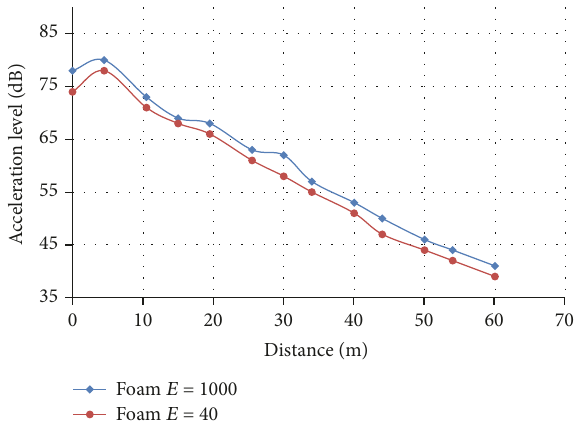
Figure 14: The comparison of acceleration between case 1 and case 6 in Scheme 4